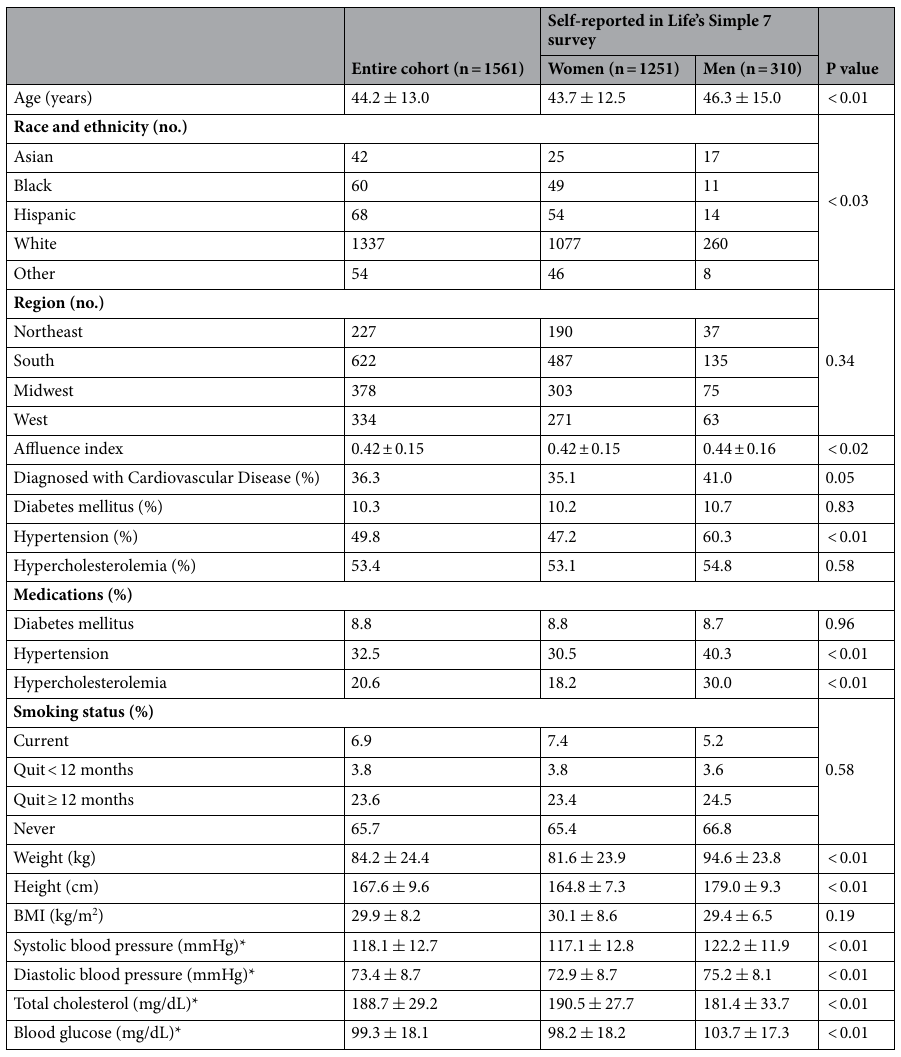
Table 1. Participant self-reported demographics and cardiovascular health. *Contains data imputed from Life’s Simple 7. Categorical variables are analyzed by Chi-Square test. Continuous variables are analyzed by t-test. Non-parametric variables were analyzed by Wilcoxon rank-sum